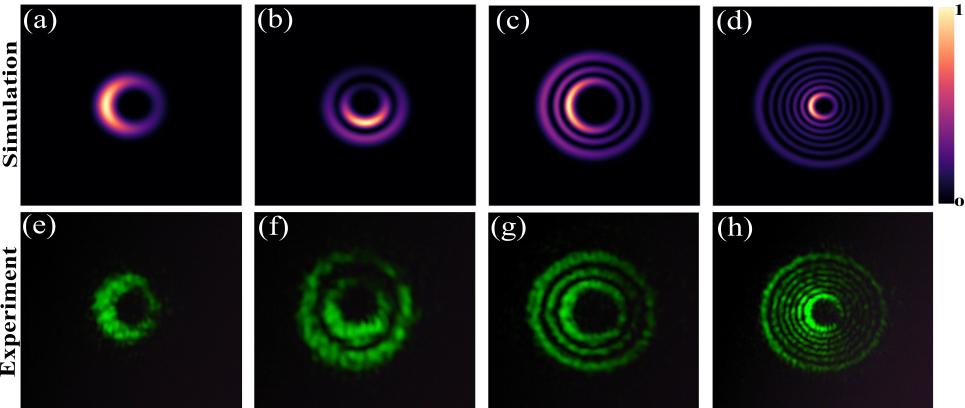
Figure 6. Simulated (first row) and experimental (second row) intensity profiles of asymmetric LG beam for w 0 = 1.5 mm, λ = 532 nm, ( a , e ) x 0 = 0, y 0 = − 0.0001 i , p = 0, l = 5, ( b , f ) x 0 = 0.0001 i , y 0 = 0, p = 1, l = 5, ( c , g ) x 0 = 0, y 0 = − 0.0001 i , p = 2, l = 10 and ( d , h ) x 0 = 0, y 0 = − 0.0001 i , p = 6, l =